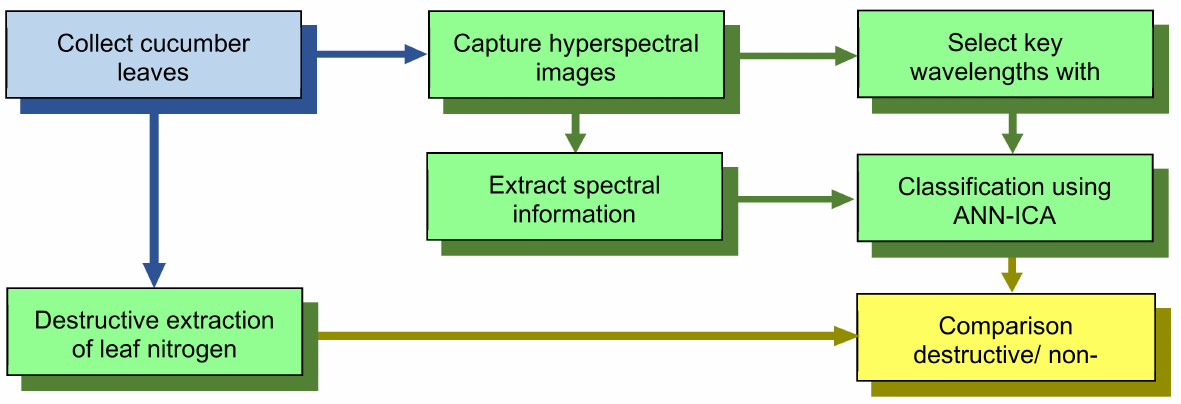
Figure 1. Different stages of the proposed methodology for classifying cucumber plant nitrogen content. ANN-ABC: artificial neural networks and artificial bee colony algorithm. ANN-ICA: artificial neural networks and imperialist competitive